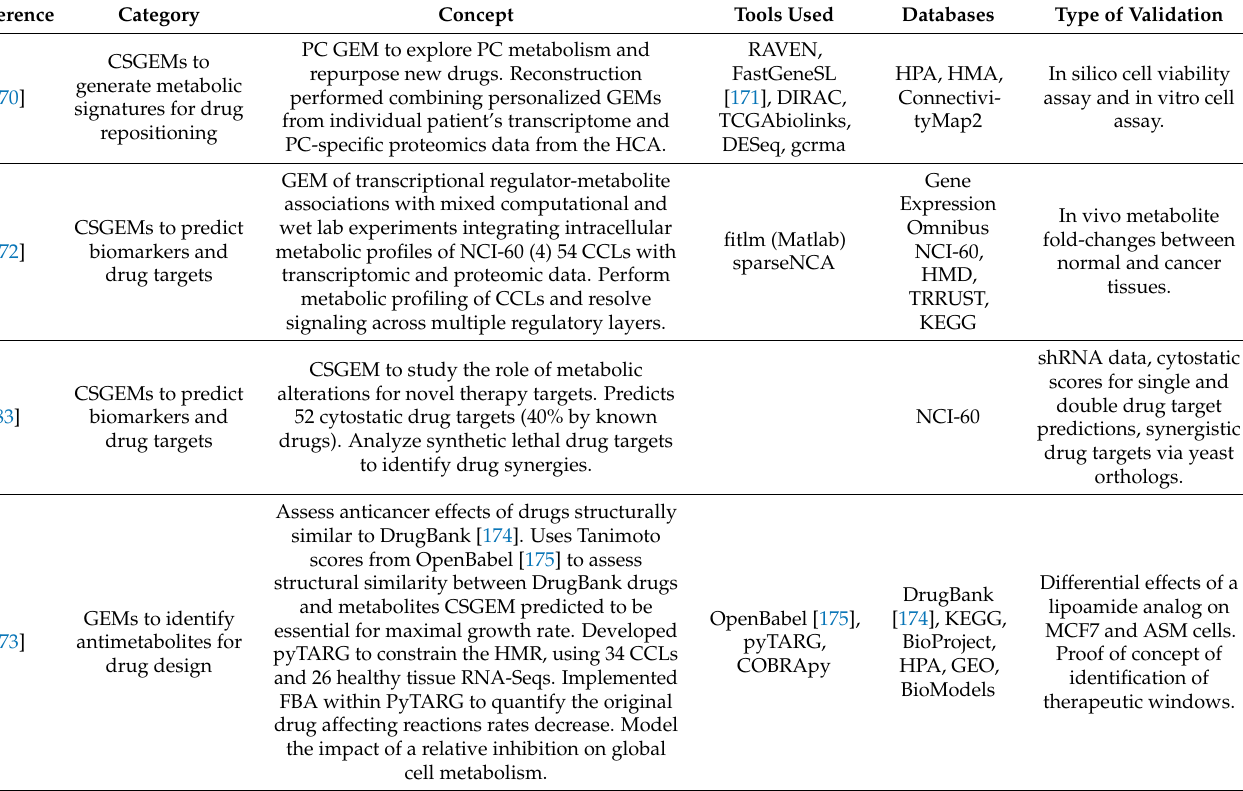
Table 3. Application of GEMs in metabolic cancer